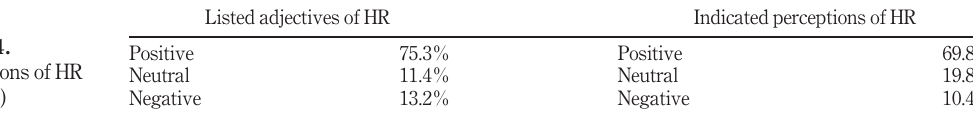
Listed adjectives of